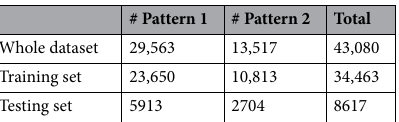
Table 2. Daily heat load variation data partitioning results.